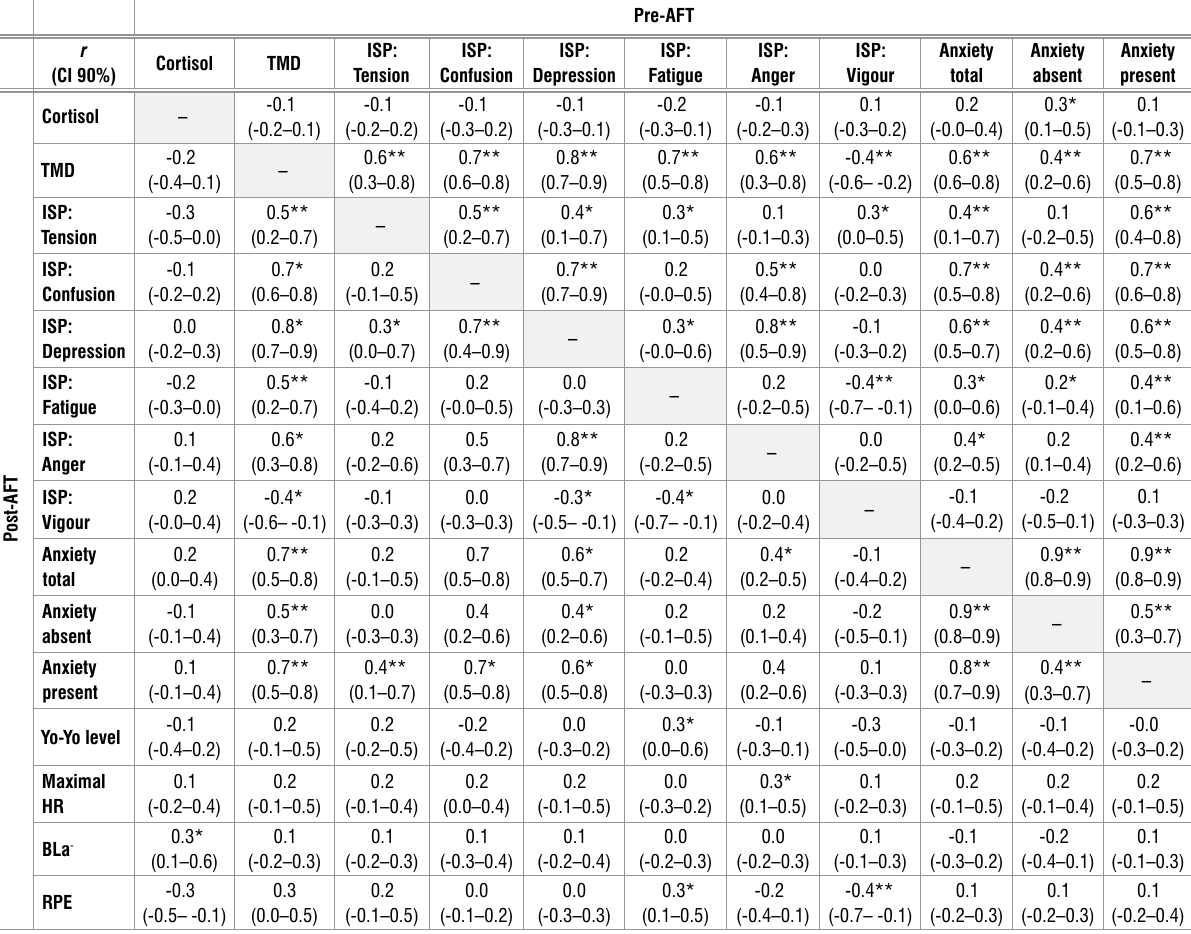
Correlation coefficient ( r ) at the 90% CI at pre- and